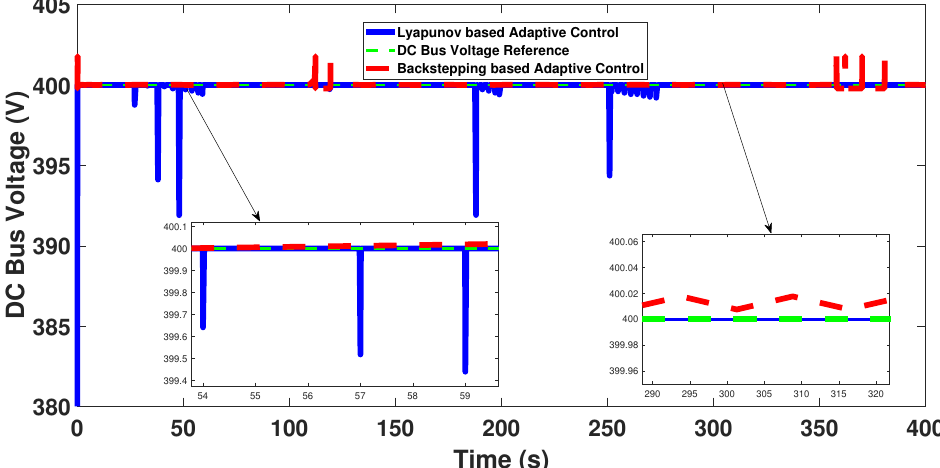
Figure 9. DC Bus voltage tracking